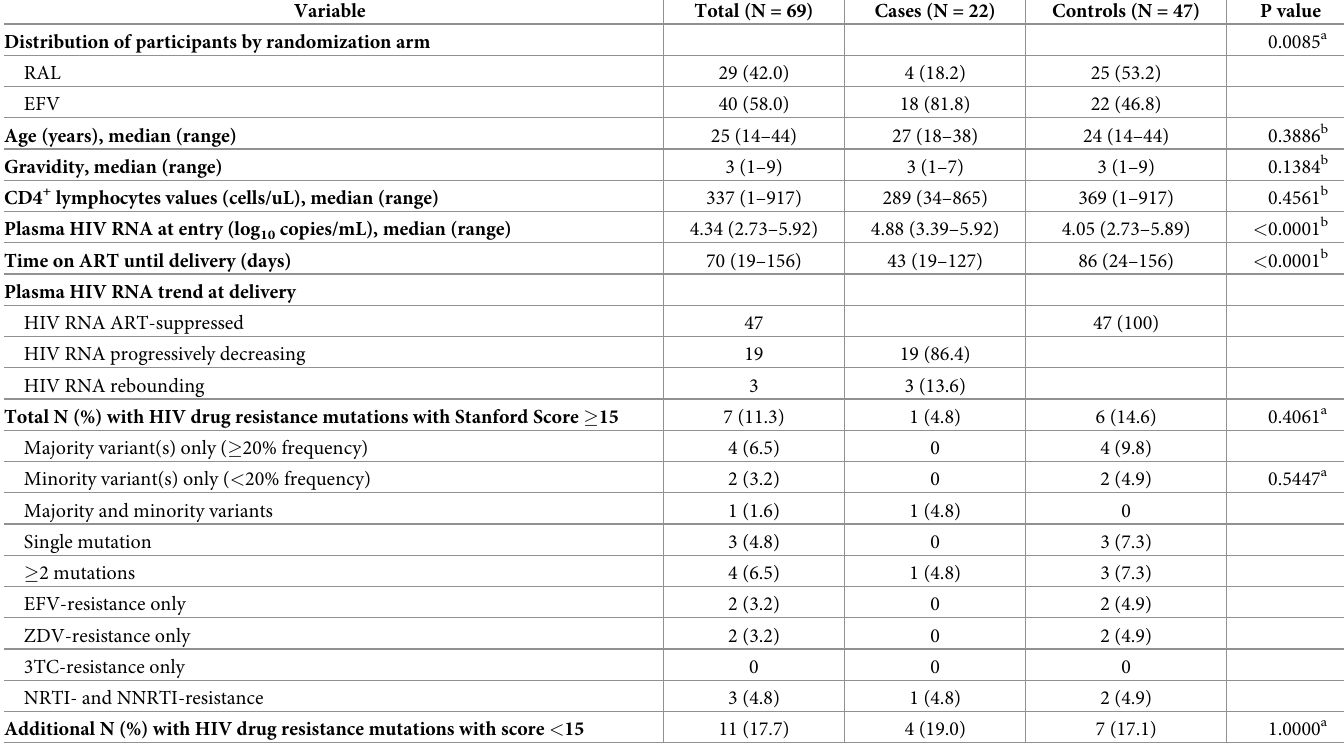
Table 1. Comparison of Pre-ART HIV drug resistance mutations detected by Illumina sequencing in participants with virologic non-suppression at term vs. ART- suppressed control women. Variable